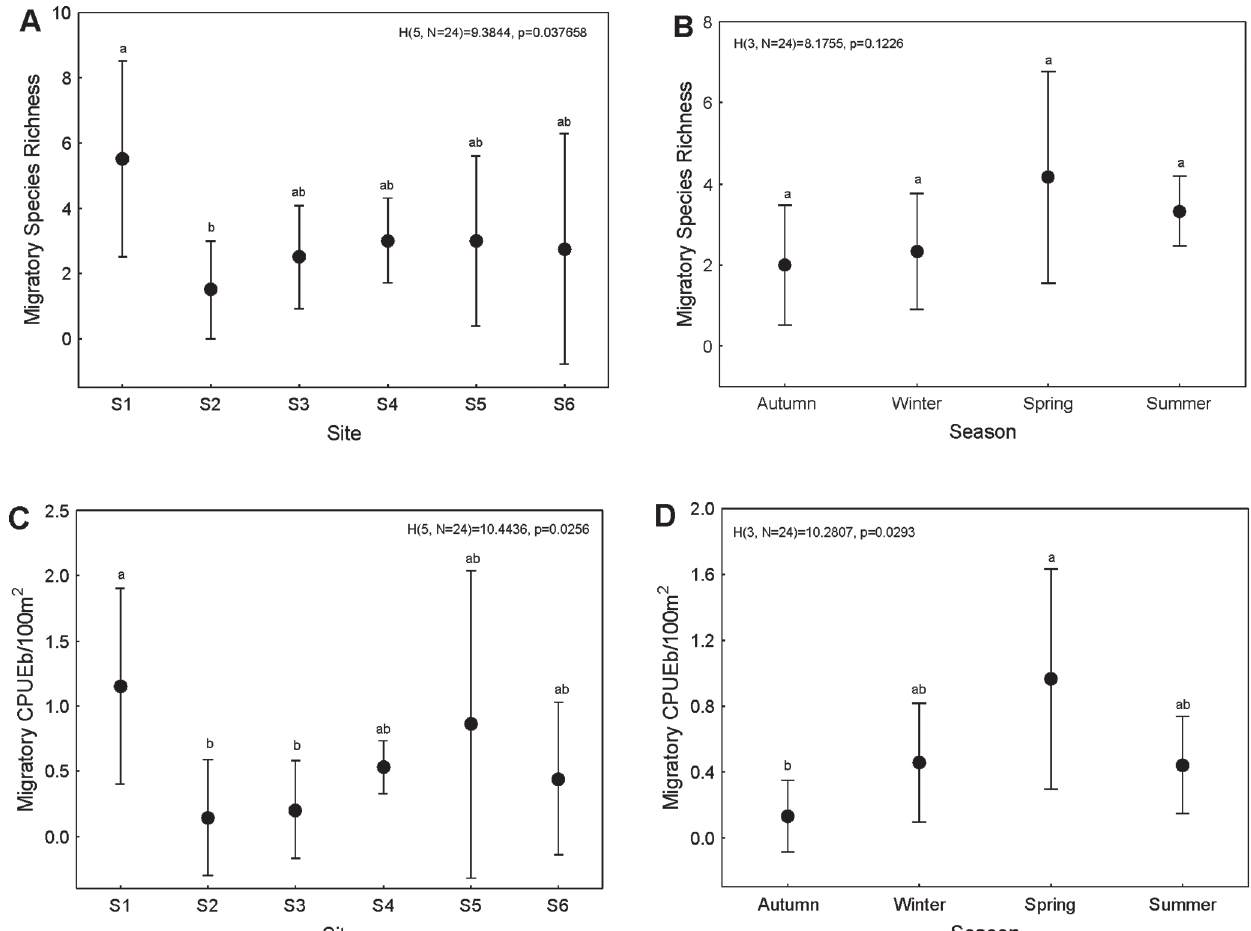
Fig. 3. Variation (mean ±standard deviation) in species richness and biomass (CPUEb/100m 2 ) of migratory fishes along the river channel (A and C) and among seasons (B and D), in the Middle Uruguay River. Sites: S1 = upstream; S6 = downstream. Different letters indicate statistical difference (p <